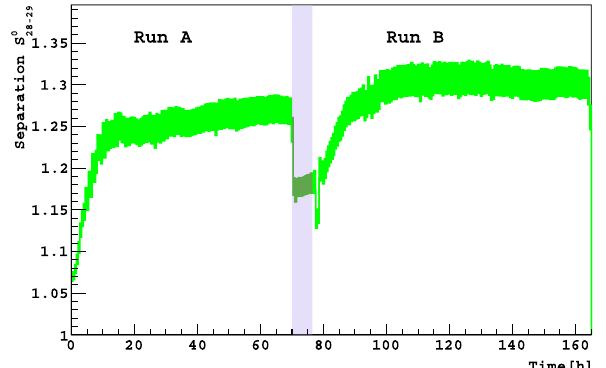
Fig. 17 Separation factor S 0 for 29 N 2 – 28 N 2 distillation in the pro- 28 − 29 totype plant. The band represent the systematic uncertainty from the spectrometer calibration